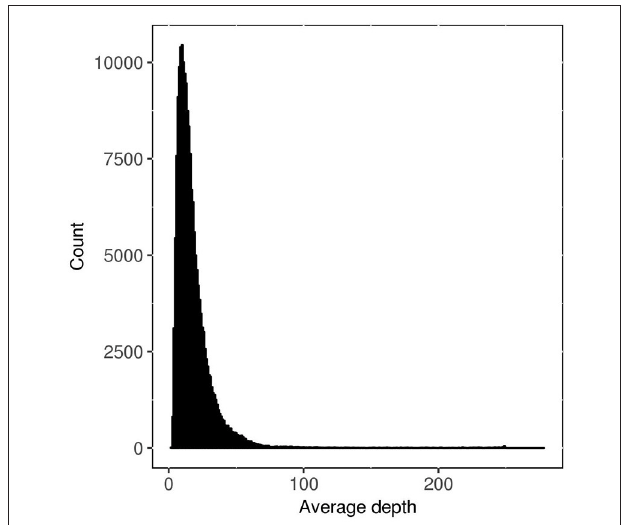
FIGURE 1 | Distribution of average read depth for each SNP before filtering by different strategies.